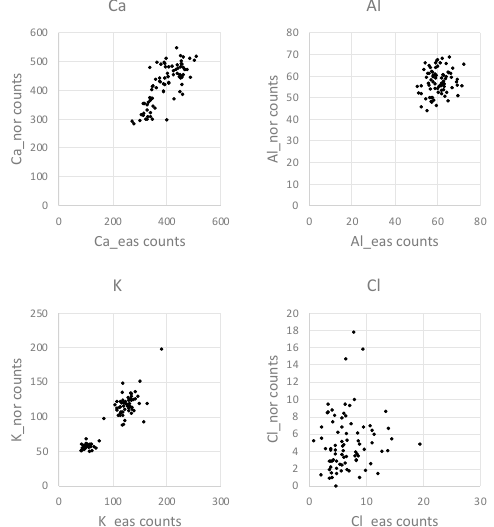
Figure 5. An example of elemental correlations in tree rings in pine #1. Every point is the mean elemental count in a tree ring taken in the east direction vs. the mean count in this same tree ring taken in the northern direction.